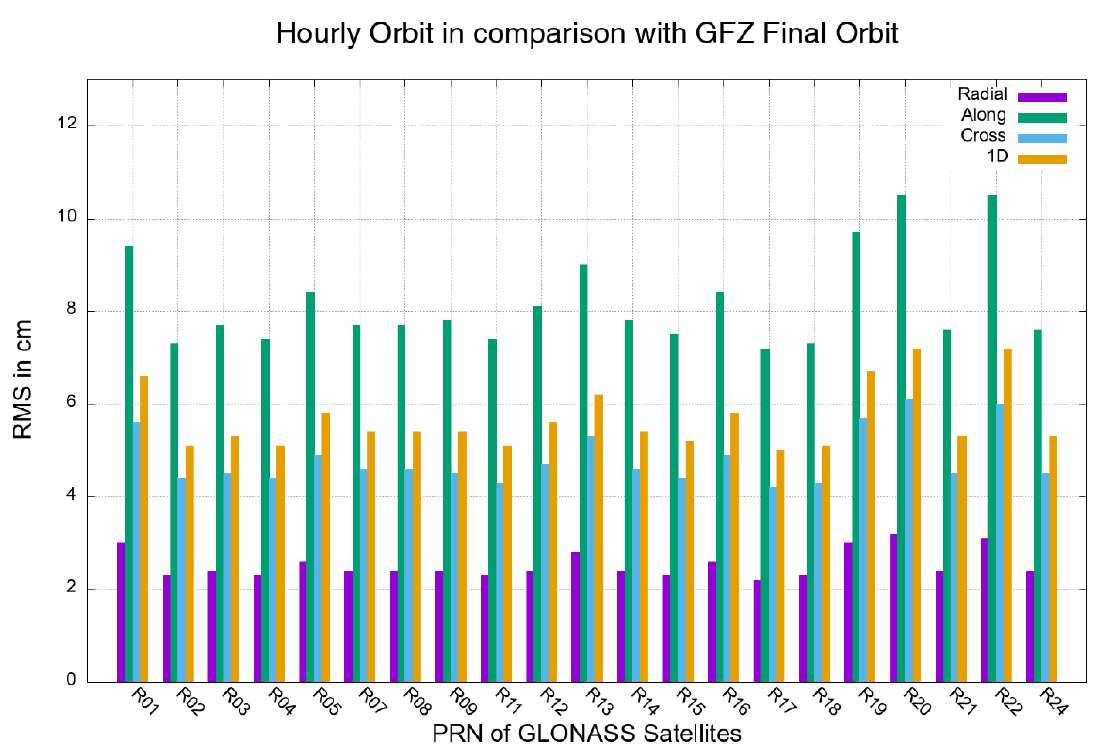
Figure 5. Mean RMS in the RAC components and 1-D of BDS NONE GEO satellites in comparison with GFZ final orbit.